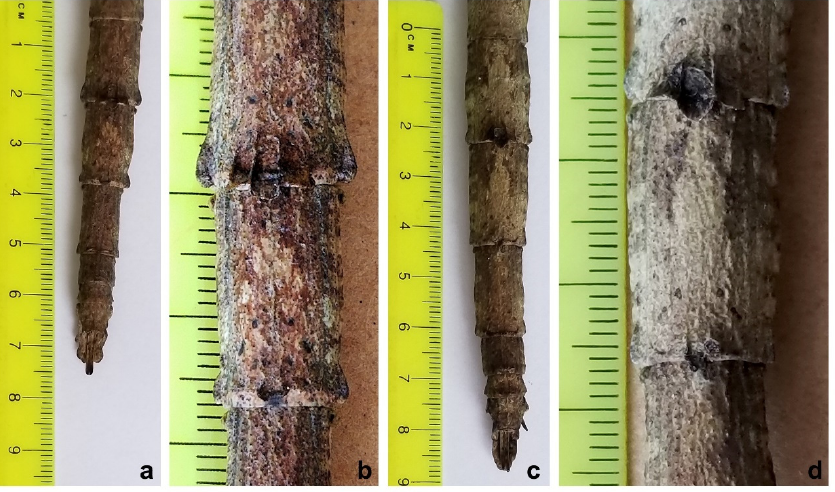
Figure 5. General aspect of the last abdominal segments and details of the fourth and fifth segments. ( a , b ) Cladomorphus petropolisensis ; ( c , d ) C. phyllinus .